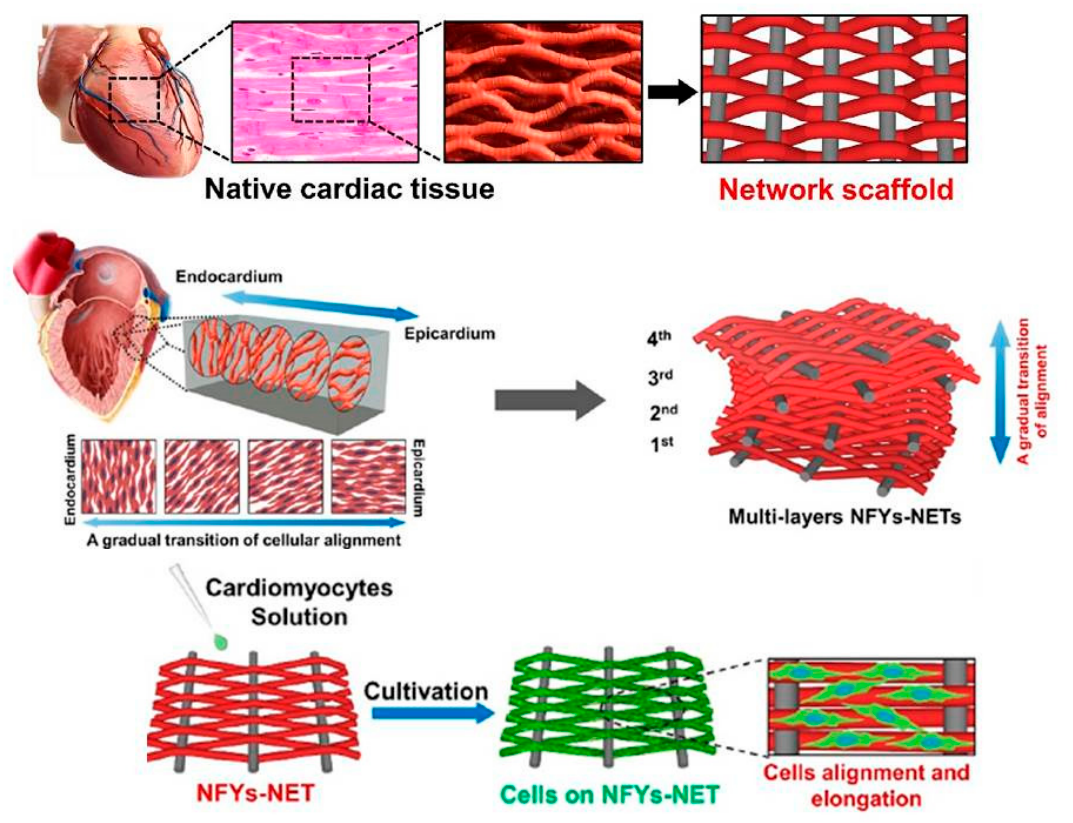
Figure 7. An interwoven structure of cardiac with aligned cell layers and biomimic scaffold with similar structure. Multiple layers of Yarn nanofiber can recapitulate the cardiac muscles which cause cell alignment and elongation [200], copyright American Chemical Society 2017.